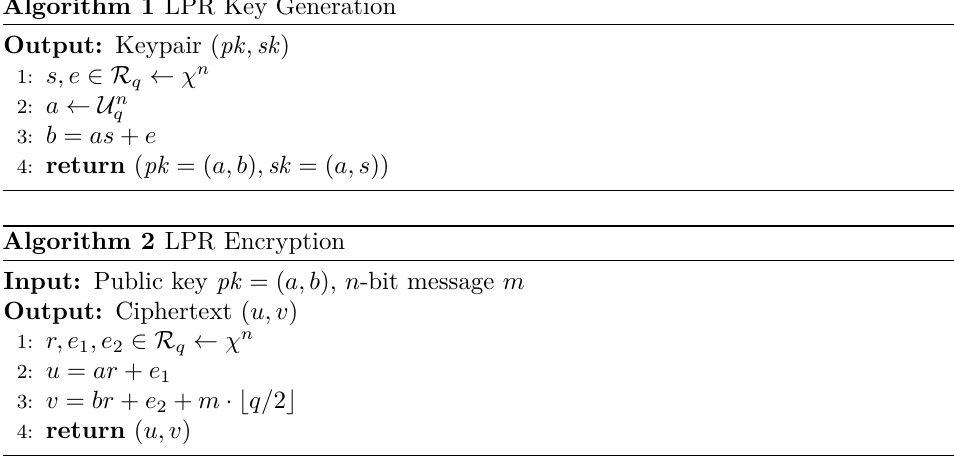
Algorithm 1 LPR Key Generation